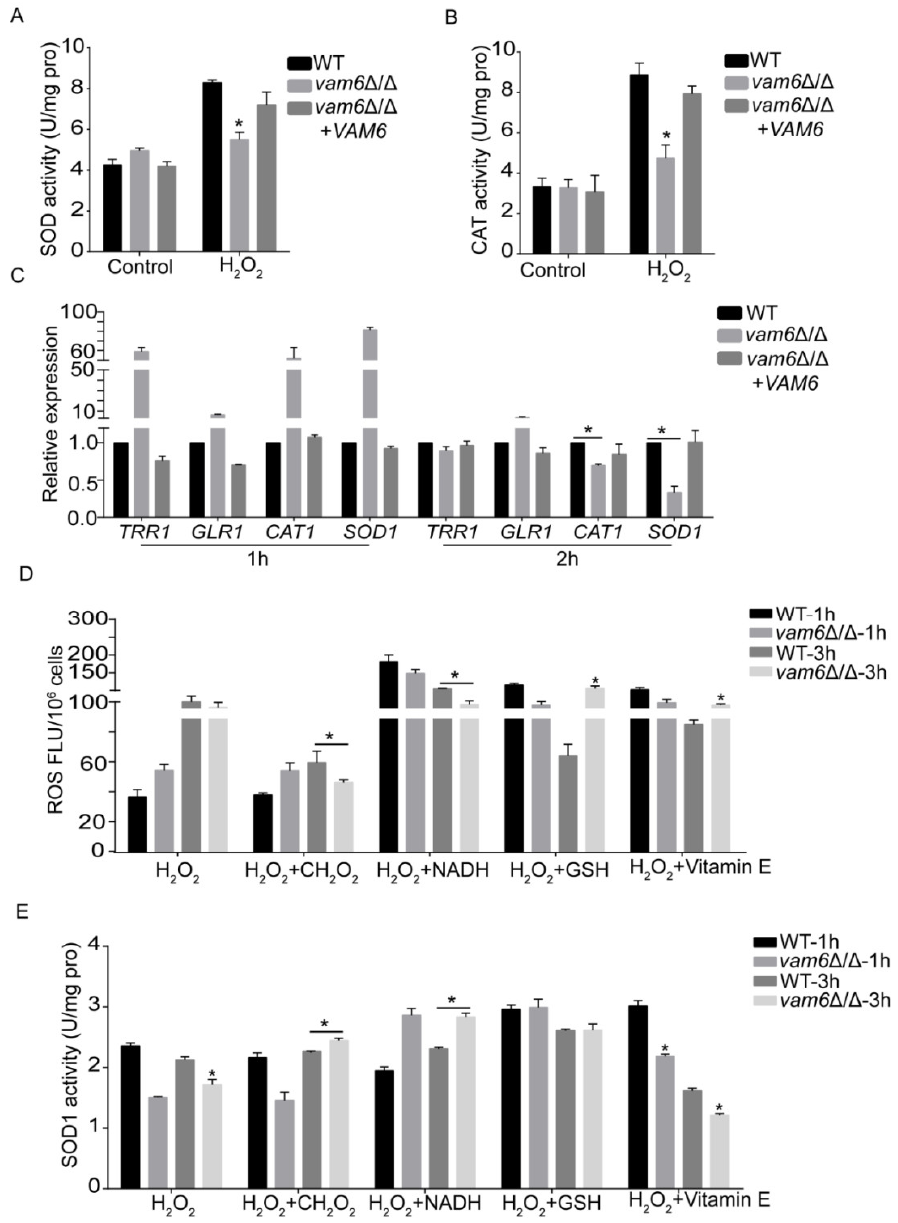
Figure 6. Deletion of VAM6 affected the antioxidant capacity of C. albicans . ( A , B ) Activity of SOD ( A ) and CAT ( B ) in the strains treated by 5 mM H 2 O 2 or not. ( C ) Expression levels of oxidative stress-responsive genes in the strains revealed by RT-PCR, with ACT1 as the normalization gene. ( D ) Effect of antioxidants (i.e., CH 2 O 2 , NADH, reduced glutathione (GSH), and Vitamin E) on intracellular ROS levels. Cells were cultured in YPD medium containing 5 mM H 2 O 2 plus 50 mM CH 2 O 2 , 50 µ M NADH, 10 mM GSH, 10 mM Vitamin E. After 1 h, 3 h of incubation with shaking at 30 ◦ C. ROS were determined by DCFH-DA staining. ( E ) SOD1 activity in the H 2 O 2 -treated cells. SOD1 activity of the supernatant was assessed by a SOD1 assay kit. The values represent the mean ± SD from three replicates. * indicates a significant difference between mutants and the control strains ( p <